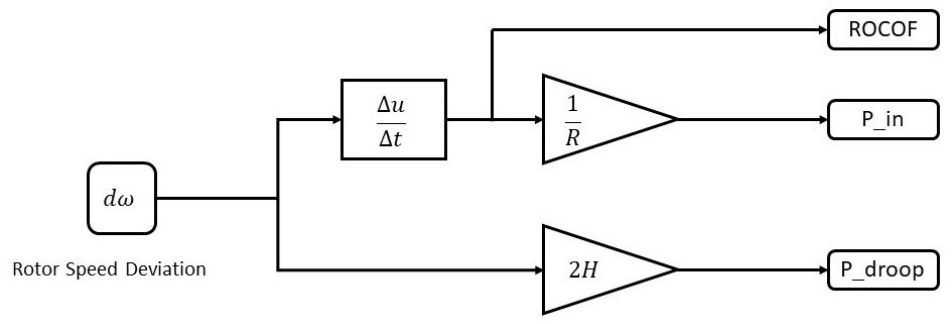
Figure 1. Frequency regulation block with inertia and droop controls.